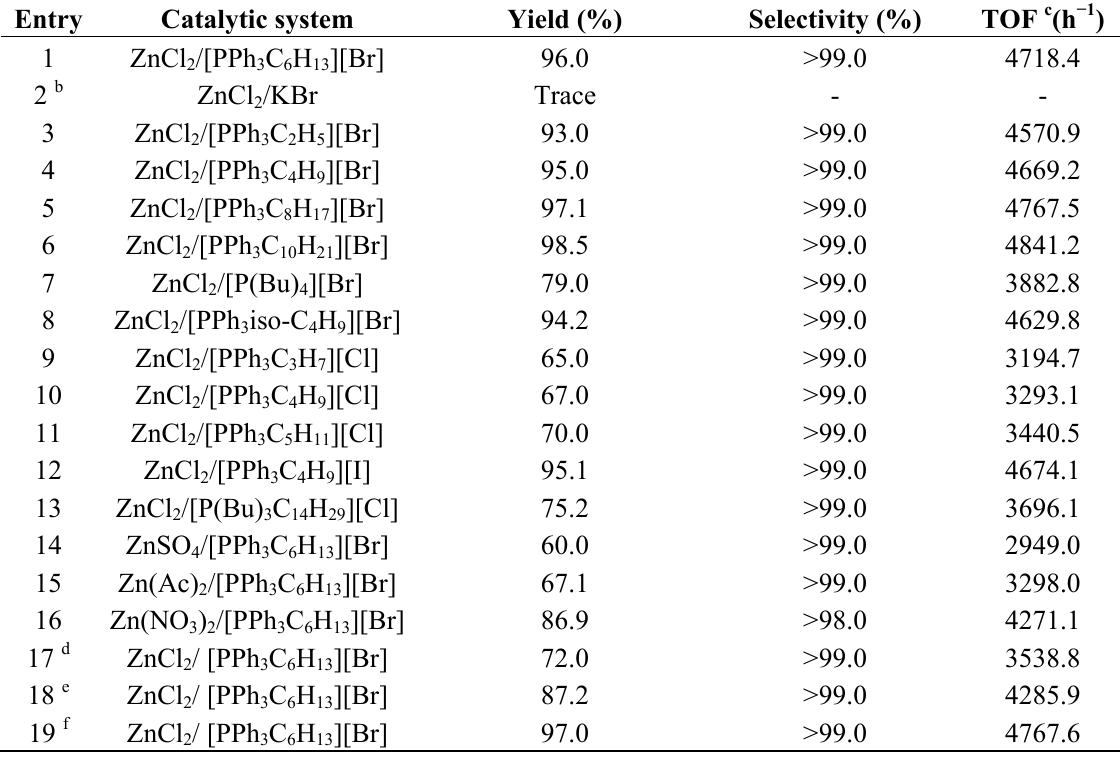
Table 2. Effects of different zinc compounds combined with phosphonium salts on the and PO a coupling reaction of CO 2